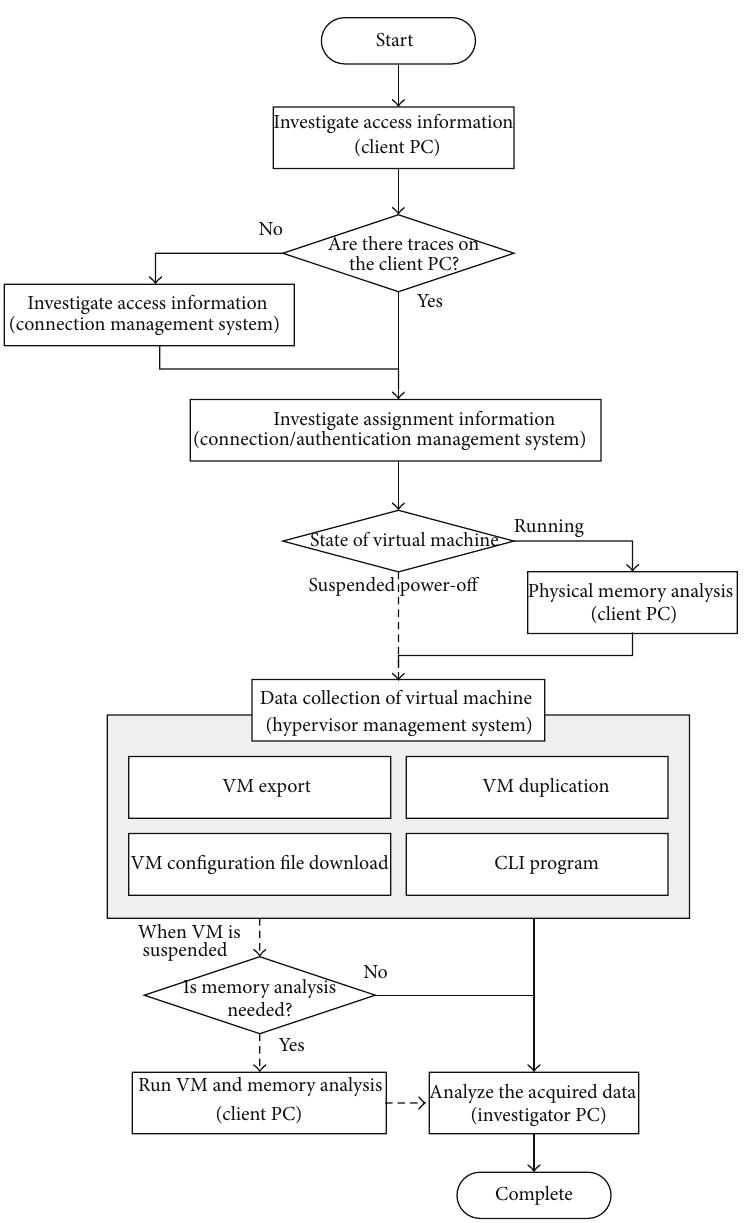
Figure 3: Digital forensics procedure for VDI in private cloud